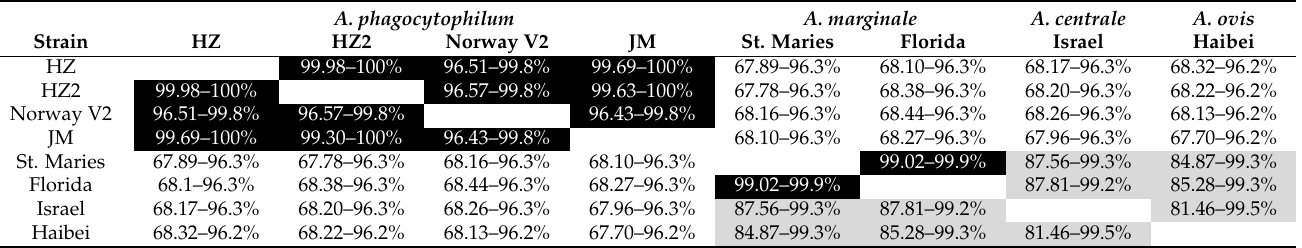
Table 1. ANI to 16S rRNA Gene Percent Identities for Anaplasma